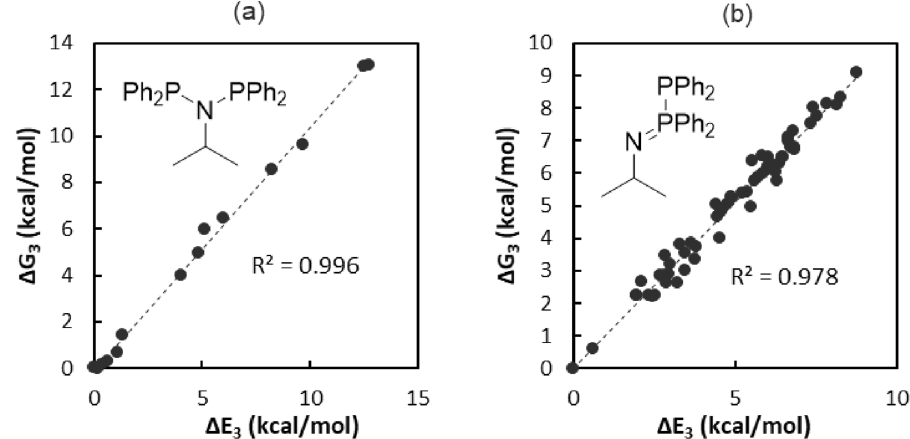
Figure 4. Comparison of relative free energies of conformers (ΔG 3 ) versus relative electronic energies of conformers (ΔE